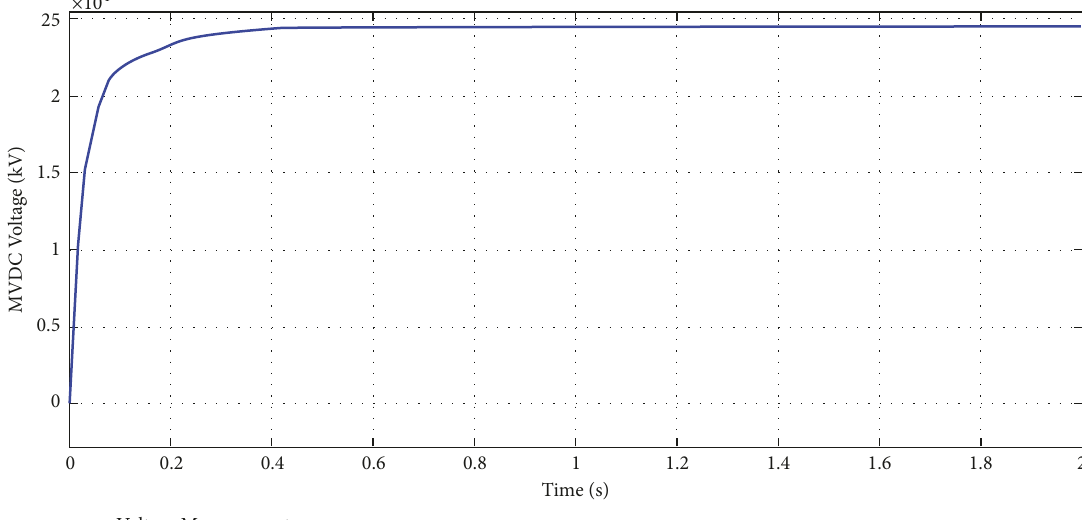
Figure 9: DC link voltage for PI with level-shifted PWM.